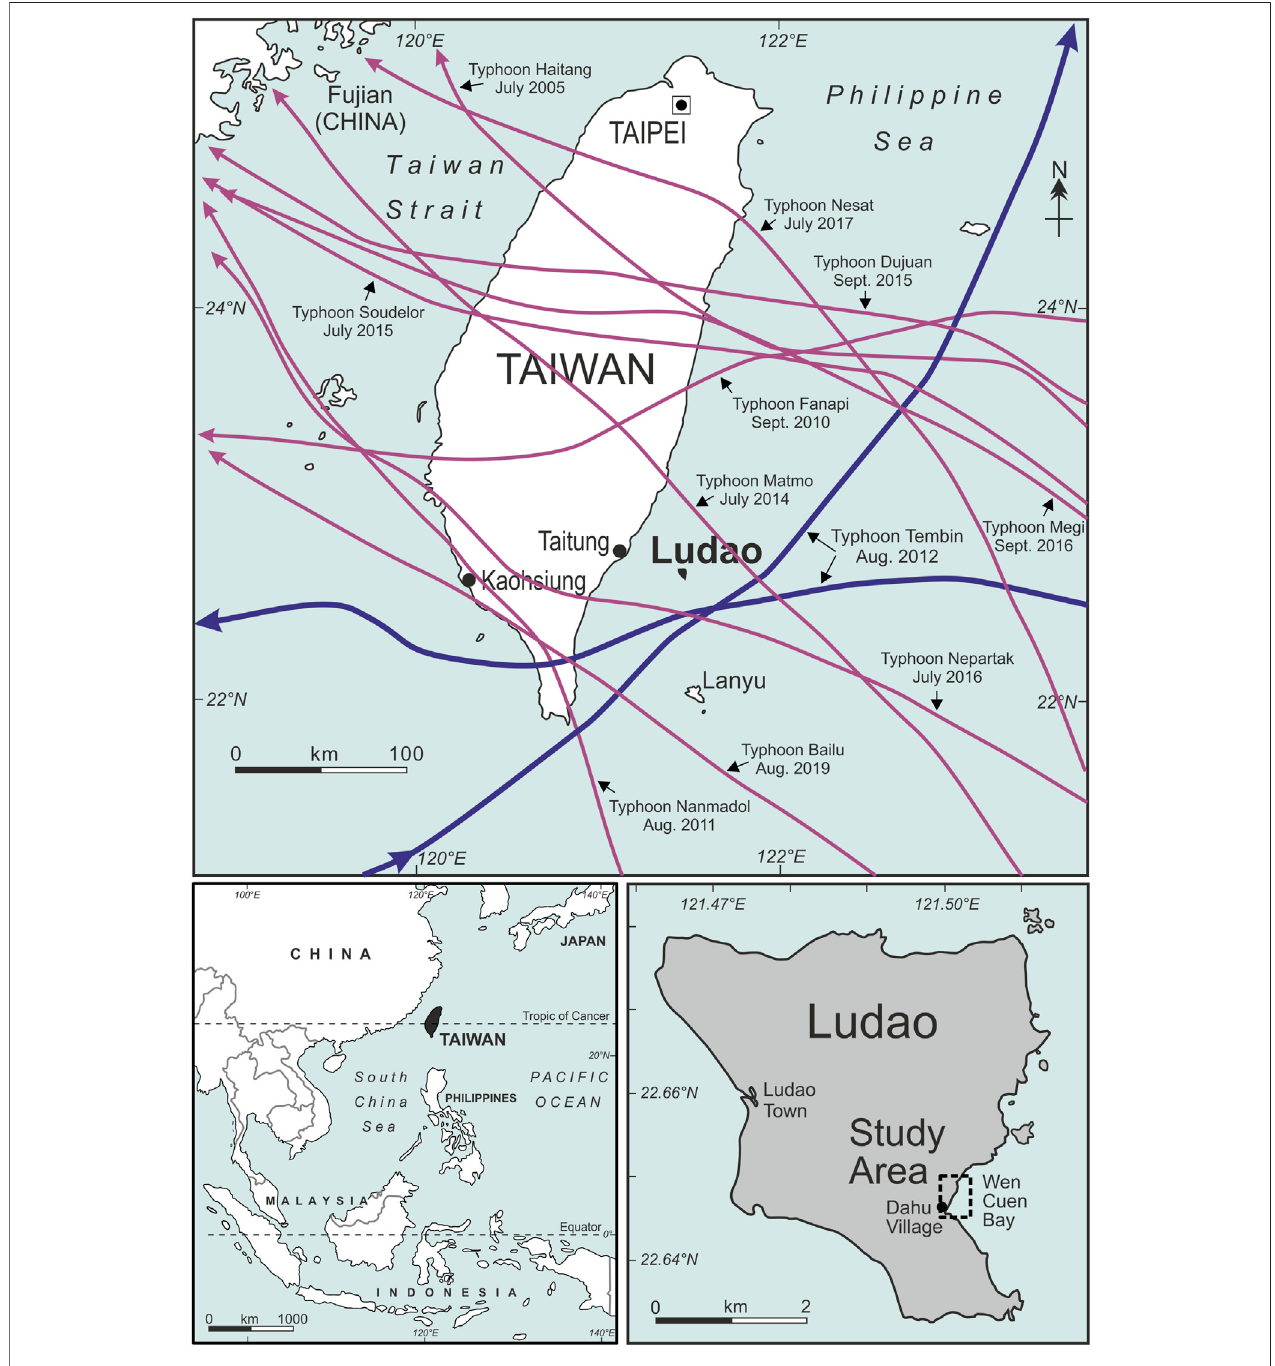
FIGURE 2 | Above: Map of all typhoons that made landfall on Taiwan over the decade 2010 – 2019. Note especially the storm track of Typhoon Tembin (blue line) that twice struck Ludao in August 2012 and prompted this investigation. Below: Location of Taiwan and the study area on Ludao island.